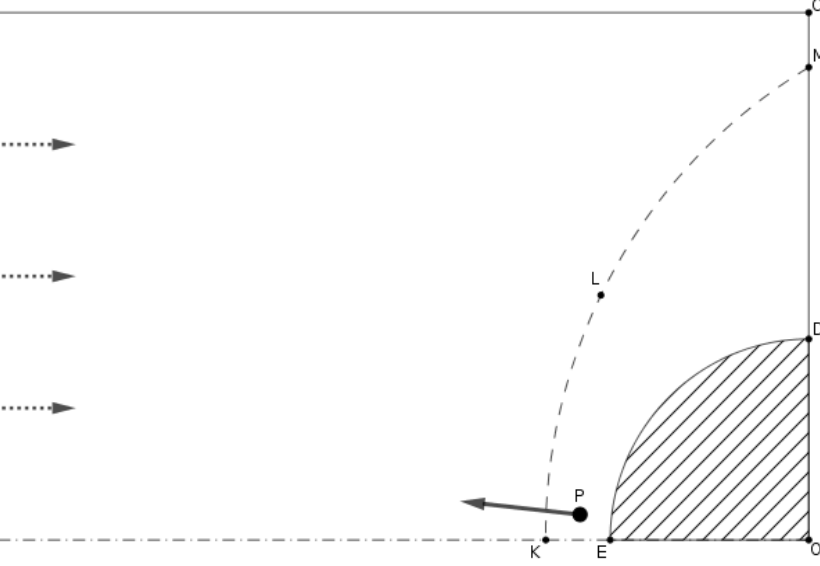
Figure 1. The computational domain: AB is the input boundary, BCD is the output boundary, ODE is a circular cylinder, P is a particle, and KLM is the shock front at the initial moment.